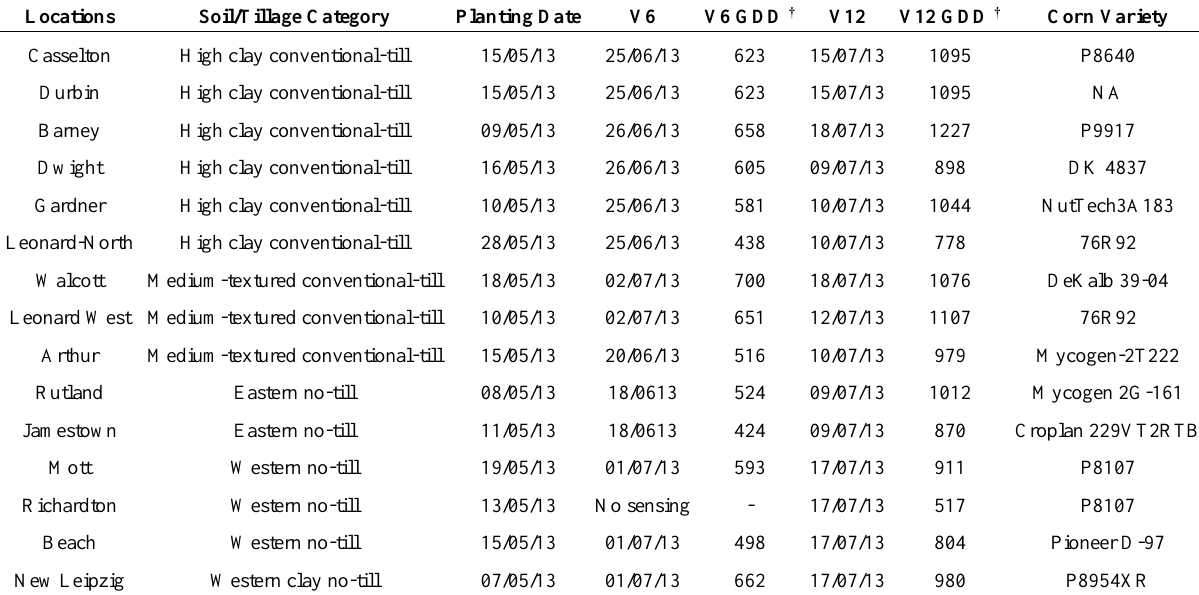
Table 2. Tillage system, planting date and date of the first and second sensing of each location in